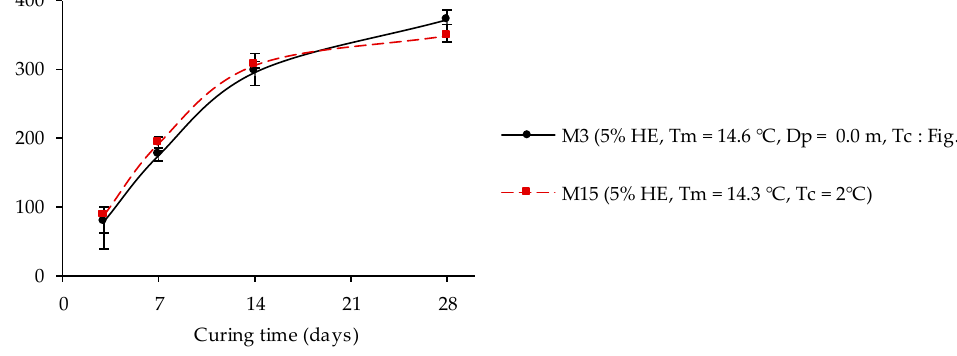
Figure 7. Effect of decreasing (M3) and constant (M15) curing temperatures on CPB strength.